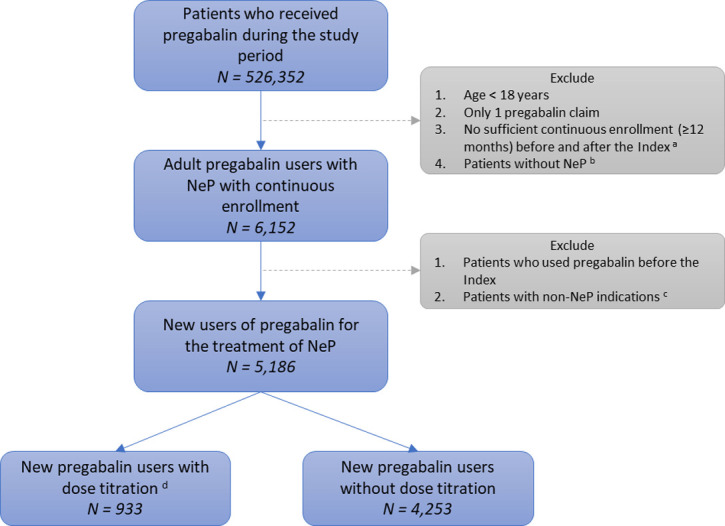
Flow chart of study sample.a. Index: first pregabalin claim. b. Neuropathic pain (NeP): diabetic peripheral neuropathy, spinal cord injury, or post-herpetic neuralgia within 12 months prior to or 1 month following the index. c. Non-NeP indications: epilepsy, fibromyalgia, amyotrophic lateral sclerosis, or multiple sclerosis. d. New pregabalin users: no pregabalin use within 12 months prior to the index.